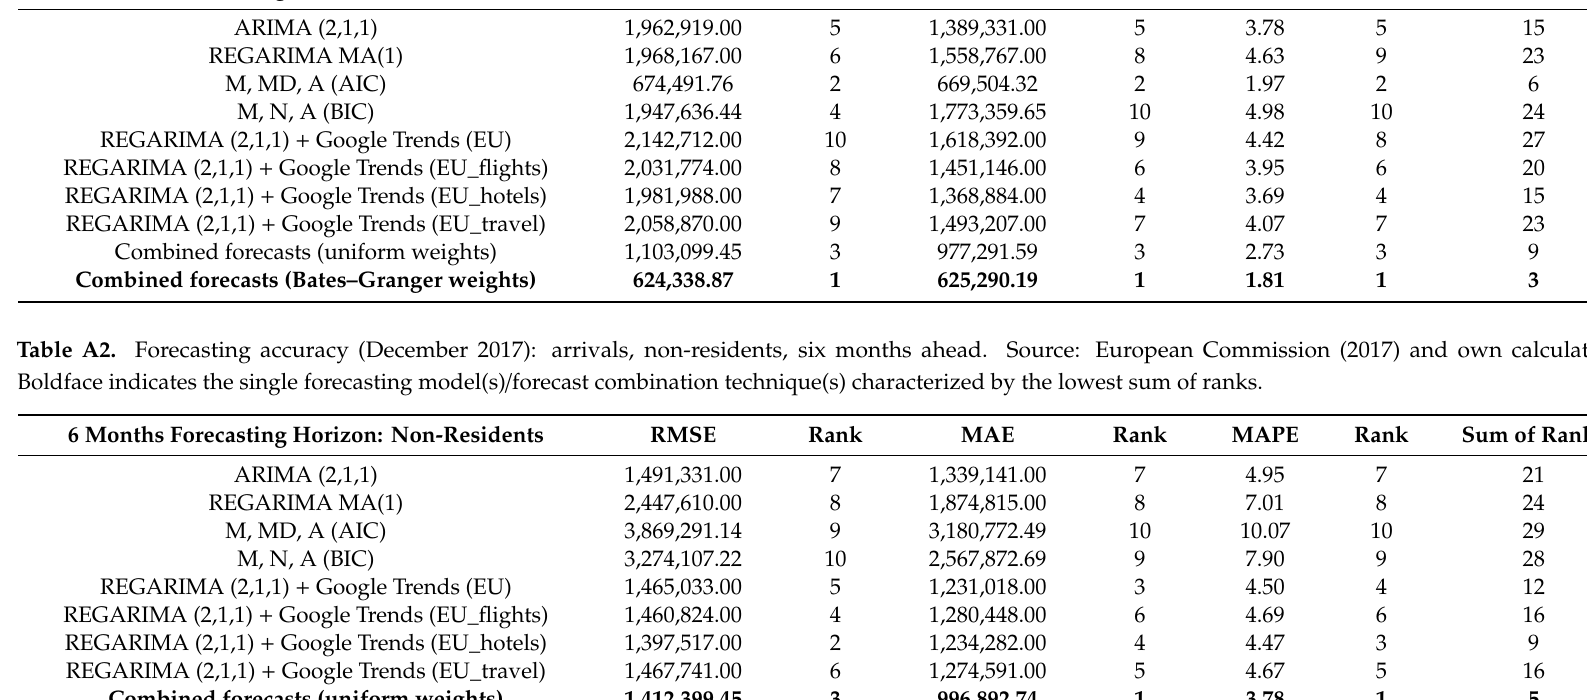
Table A1. Forecasting accuracy (December 2017): arrivals, non-residents, three months ahead. Source: European Commission (2017) and own calculations. Boldface indicates the single forecasting model(s) / forecast combination technique(s) characterized by the lowest sum of ranks. 3 Months Forecasting Horizon: Non-Residents